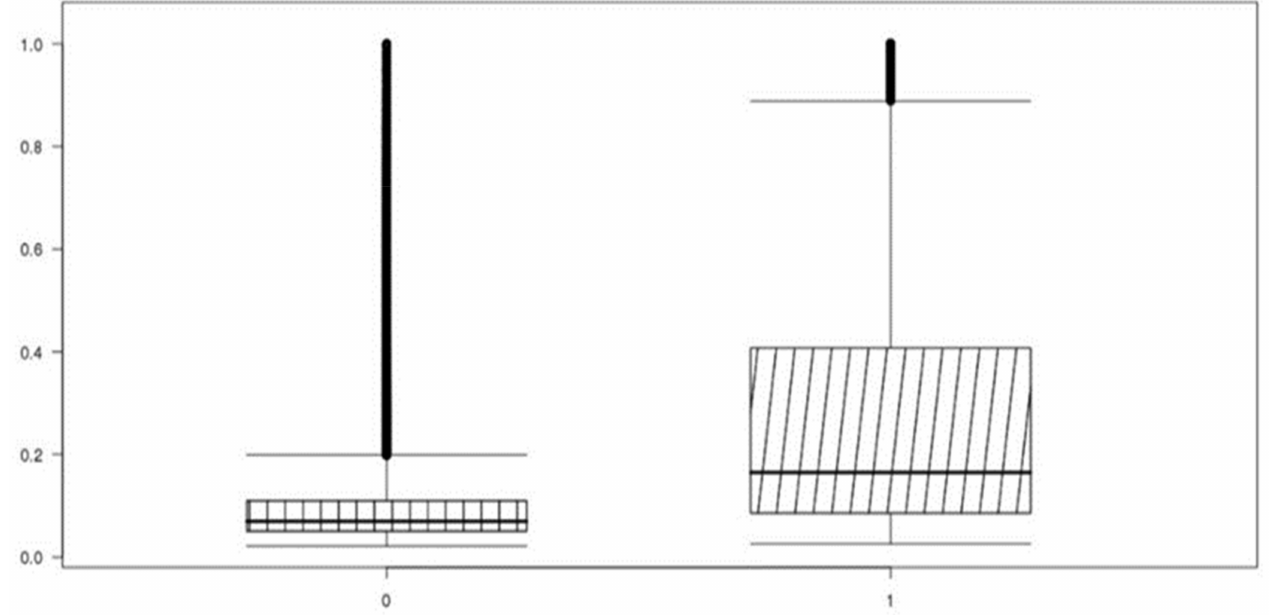
Figure 4. Raw dataset 4 (logistic regression) actual-prediction data distribution